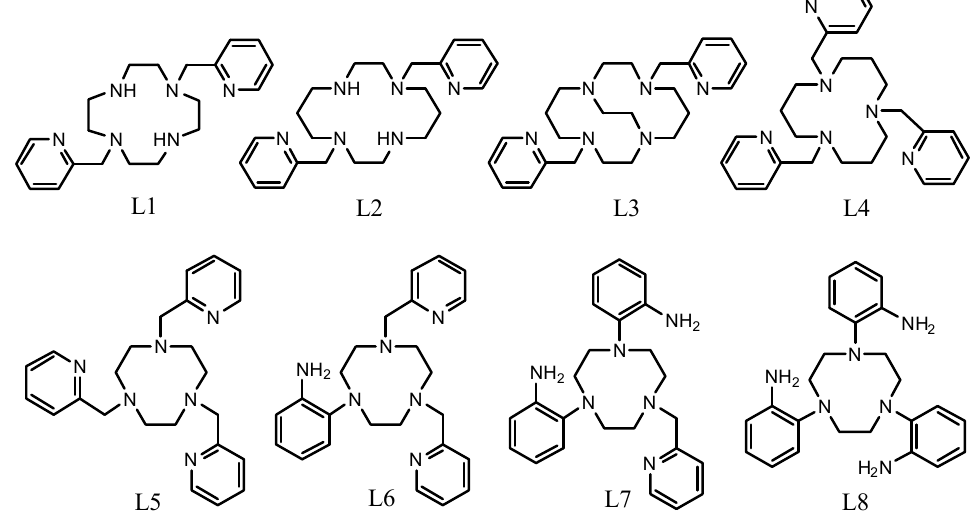
Scheme 1. Examples of hexadentate, tetra- and tri-azamacrocycle ligands involving